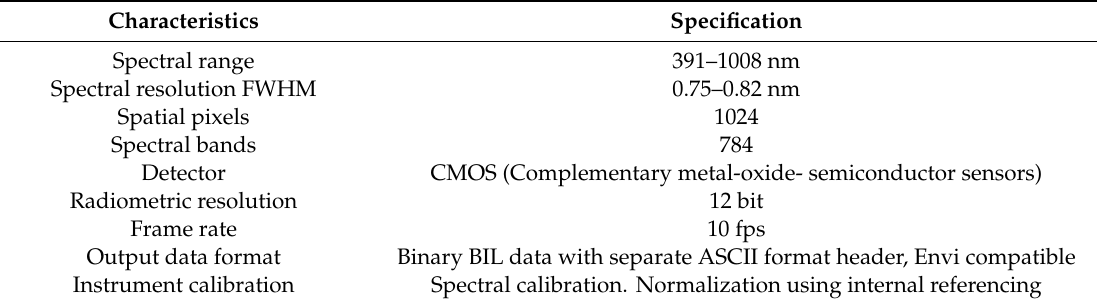
Table 2. Specim imaging spectrometer camera characteristics of the visible near-infrared (VNIR) sensor.